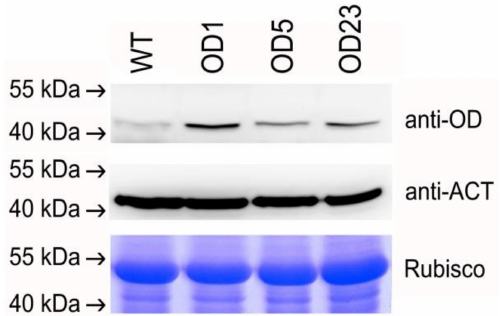
Figure 8. Western blot analysis of selected transgenic OD